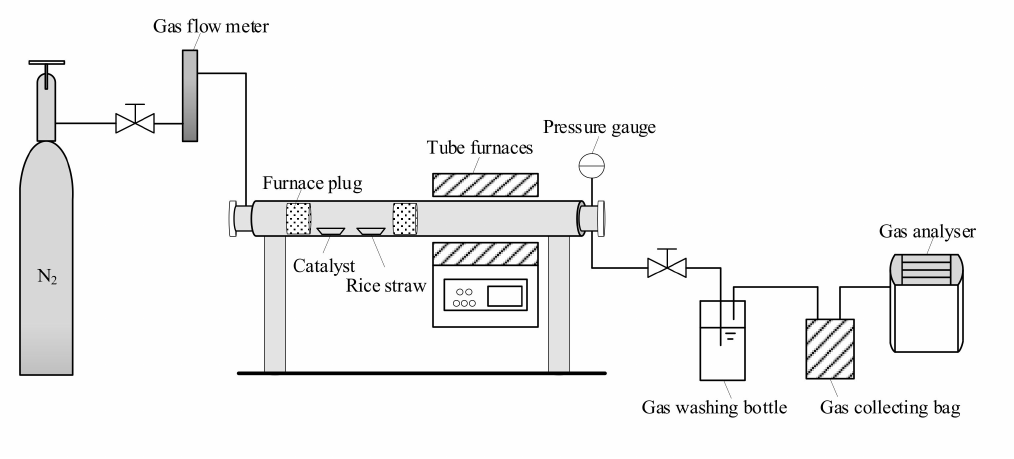
Figure 8. Experimental flow and device